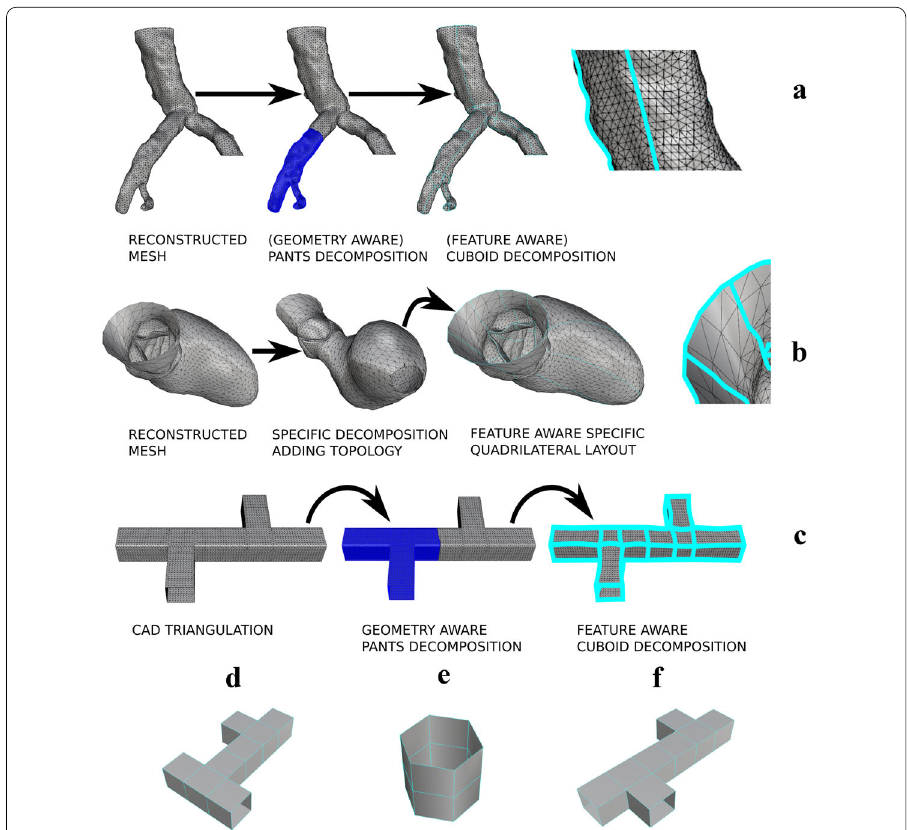
Fig. 10 Geometry-feature-aware pants-to-cuboids decomposition algorithm overview. Biological ( a , b ) and mechanical pipeline ( c ). Resulting quadrilateral layouts of ( a – c ) respectively in ( d – f